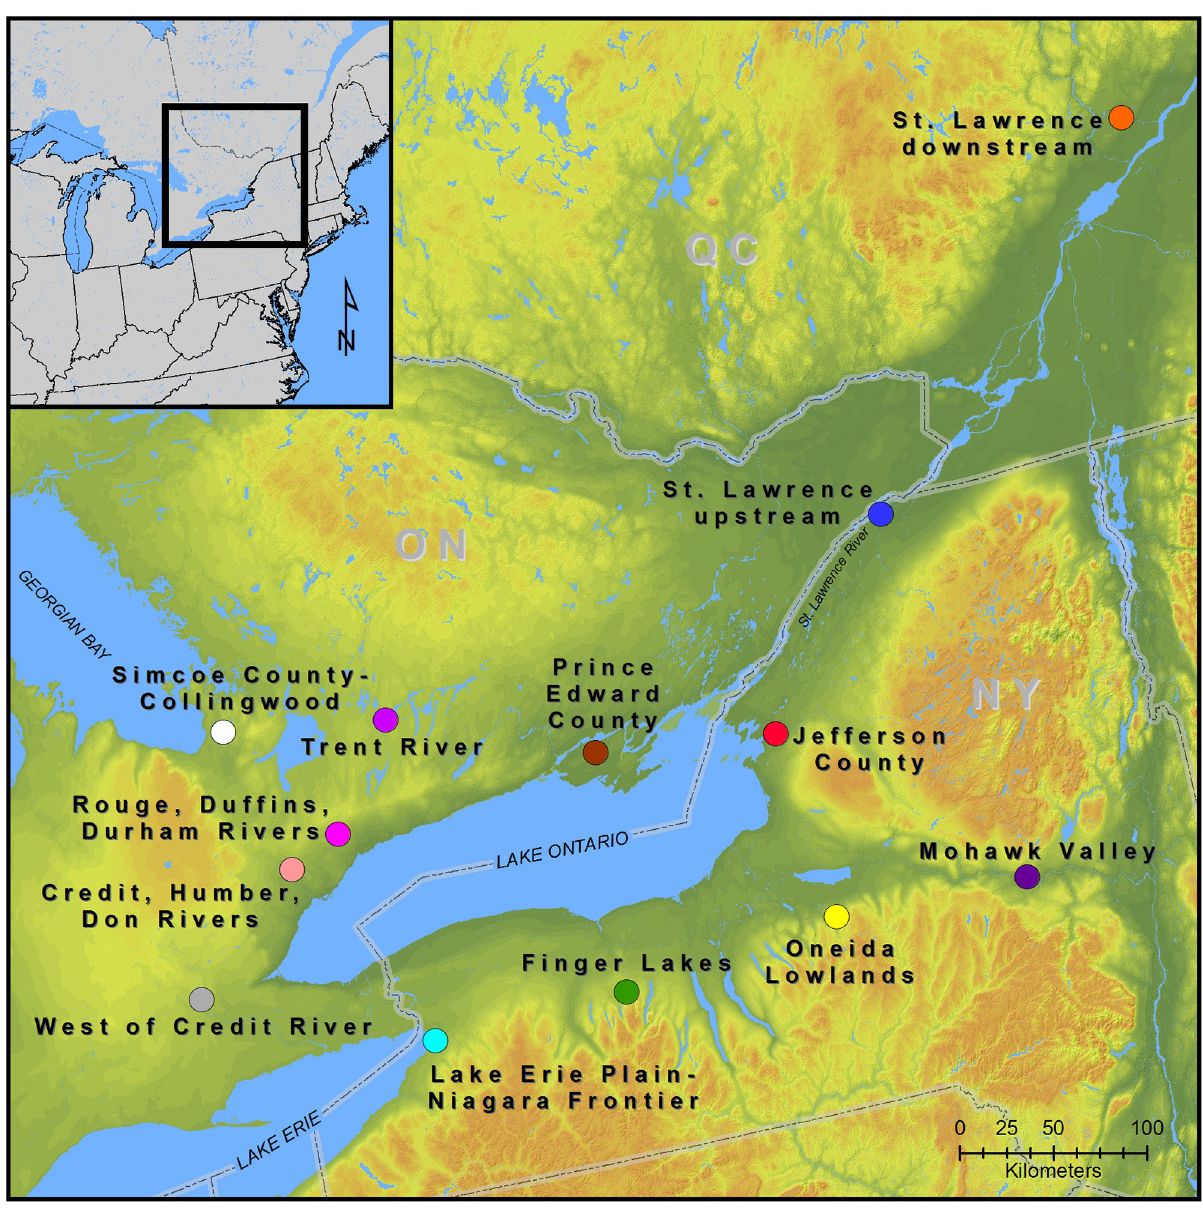
Fig 2. Map showing site cluster geographic